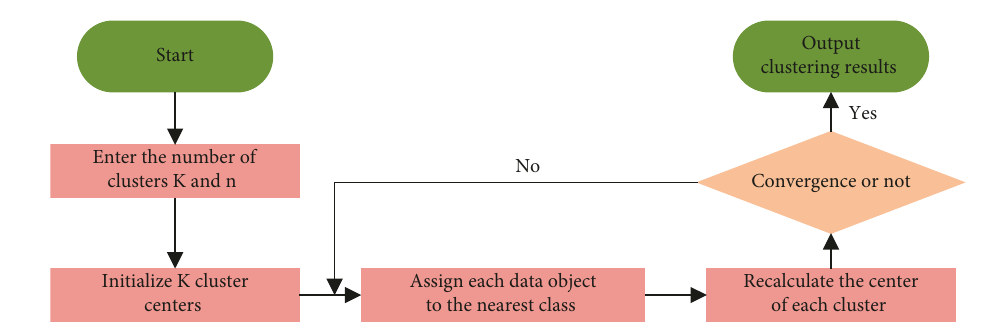
Figure 2: Flowchart of K-means algorithm.